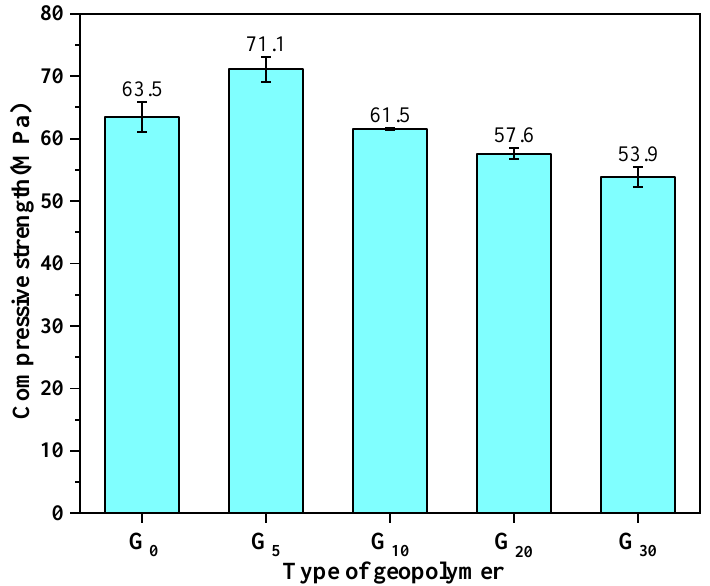
Figure 2. Compressive strength of the geopolymers containing different proportions of CEM I.